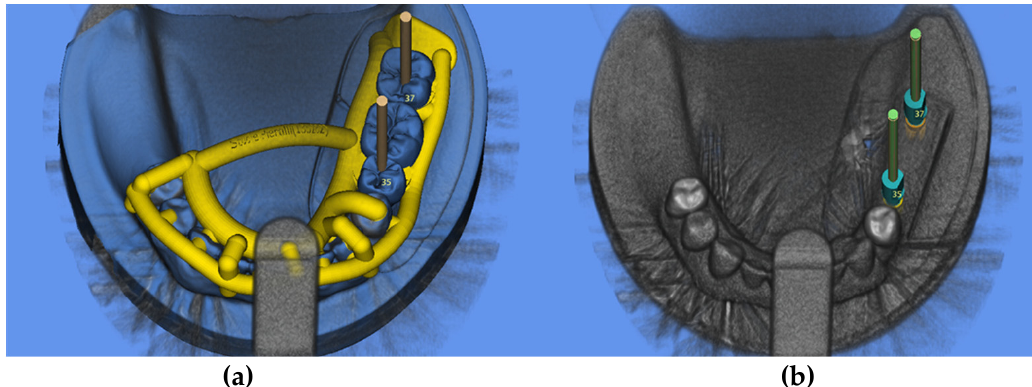
Figure 1. Digital implant planning: ( a ) design of the surgical guide, ( b ) virtual application of scan bodies (target